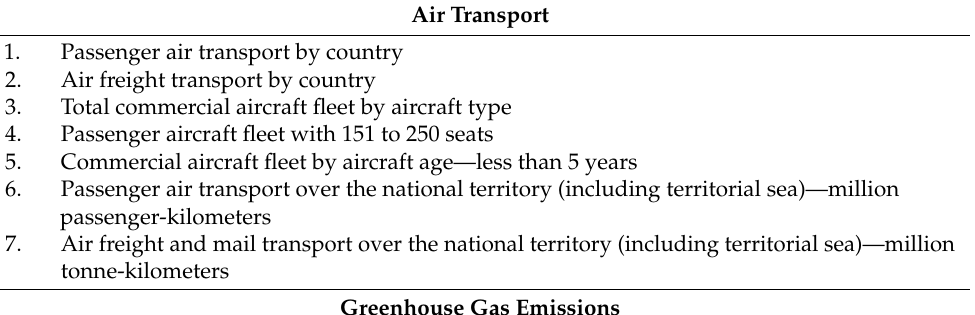
Table 1. Variables used in the